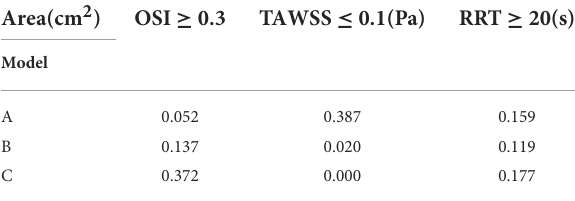
TABLE 1 Areas with an OSI > 0.3, TAWSS < 0.1Pa, and RRT > 20s in three models.